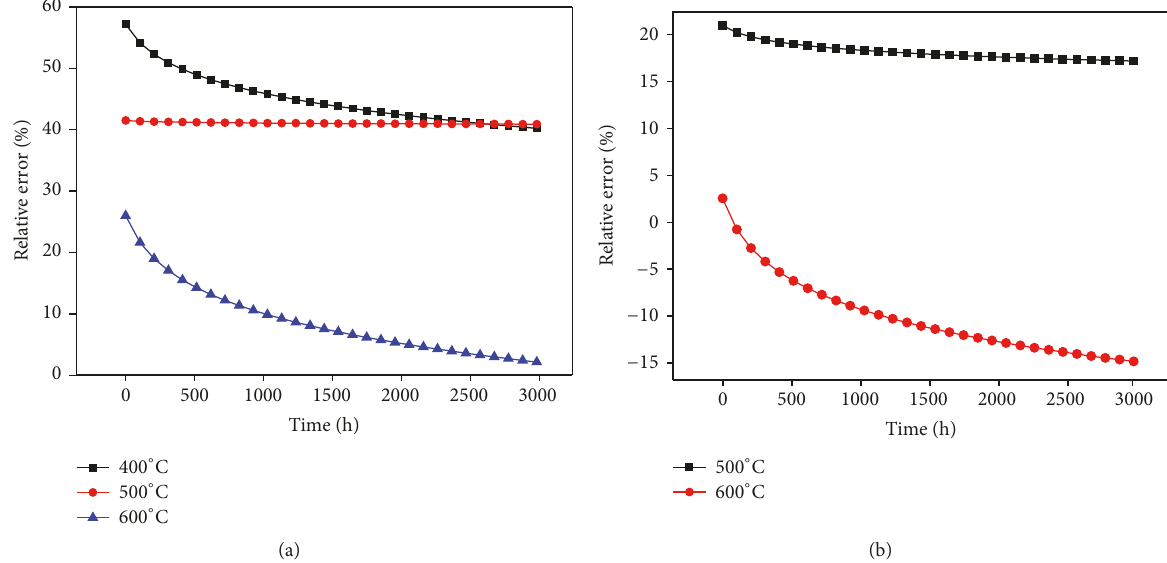
Figure 4: Relative error of simulated weight gain by oxidation of HCM12A (a) and NF616 (b) in supercritical water at different temperatures compared to the